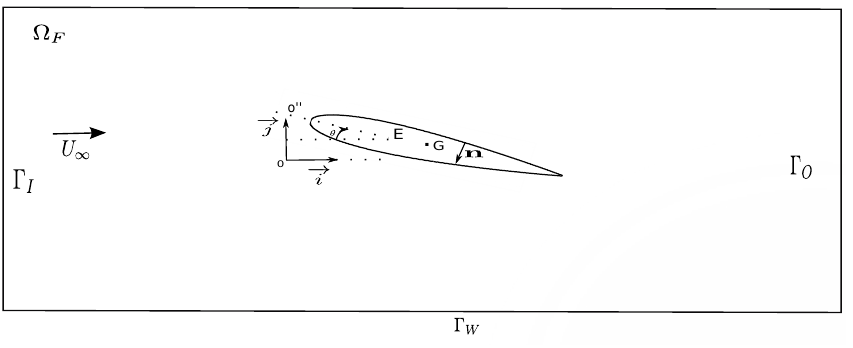
Figure 1. Fluid and Structure